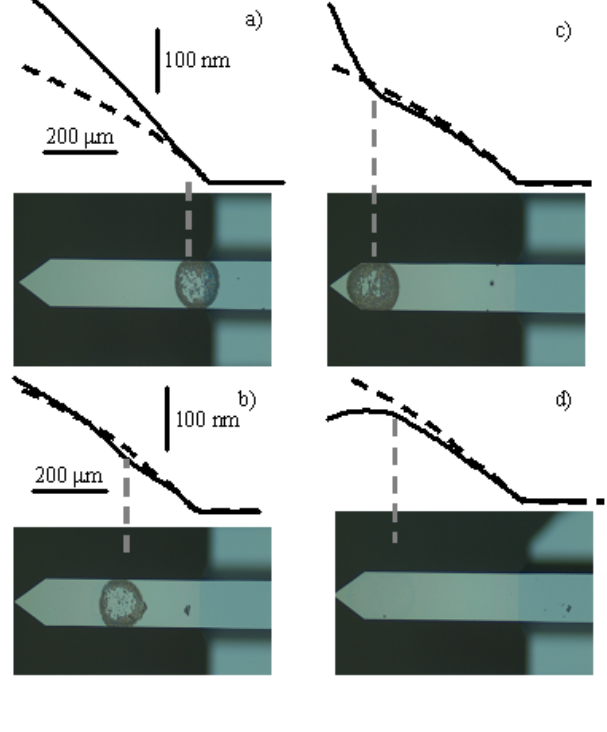
Figure 3. Optical micrographs of the cantilevers after deposition of droplets containing E. Coli bacteria. Above each picture the cantilever profile measured before (dotted line) and after (continuous line) bacteria deposition are presented. The cantilever profile is modified at the position of the adsorbed bacteria due to the induced surface stress by the adsorbed inhomogeneous layer of